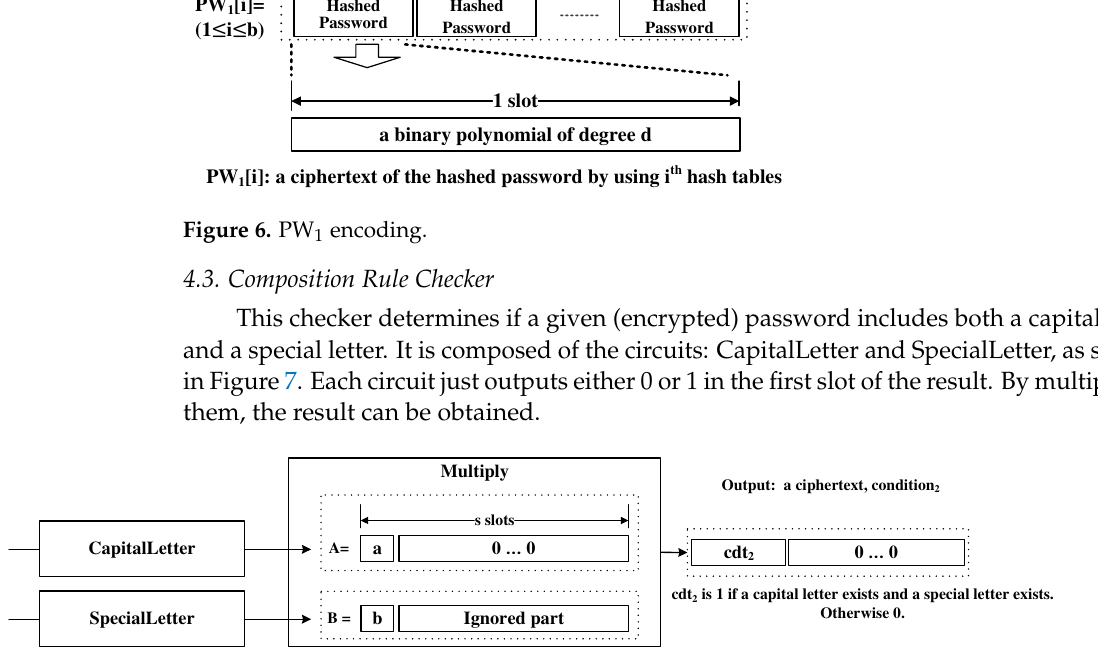
Figure 7. Composition Rule Checker.